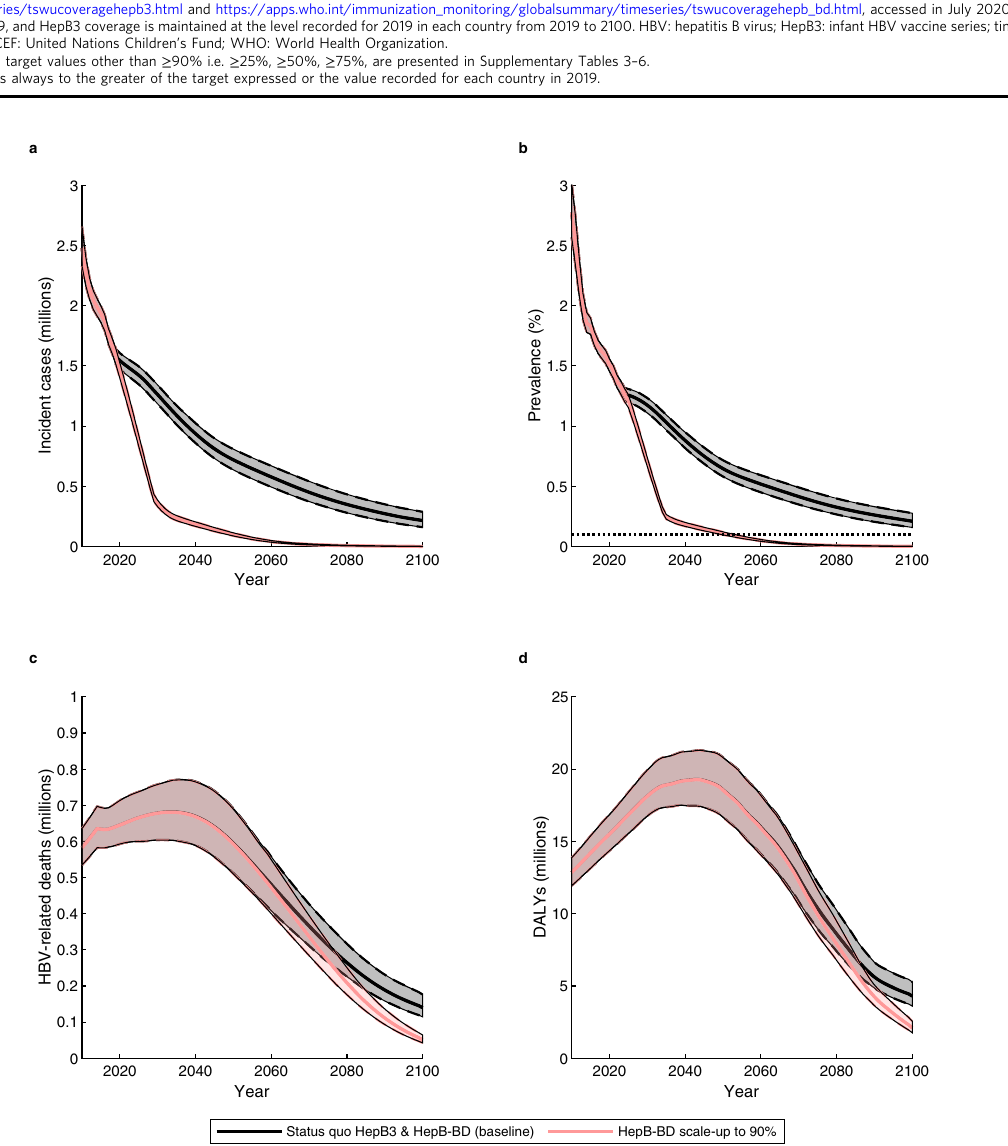
Fig. 2 The overall impact of timely HepB-BD scale-up on disease burden globally. a Incidence of new chronic carriage of HBV, b Prevalence of chronic HBsAg among fi ve-year-olds, c HBV-related deaths and d total DALYs incurred. Shown are the means (lines) and 95% credibility intervals (shaded areas), comparing the status quo HepB3 & HepB-BD scenario (black line; grey shading) with a scenario in which timely HepB-BD is given to ≥ 90% of new-borns (the HepB-BD scale-up scenario; red line and shading). Results are the sum from all modelled countries of n = 200 model outcomes resulting from 200 independent draws from the posterior distribution of each country. The horizontal dashed line in Fig. 2b represents the WHO elimination threshold of 0.1% HBsAg prevalence in fi ve-year-olds. DALY: disability adjusted life years; HBsAg: hepatitis B surface antigen; HBV: hepatitis B virus; timely HepB-BD: timely birth dose; WHO: World Health